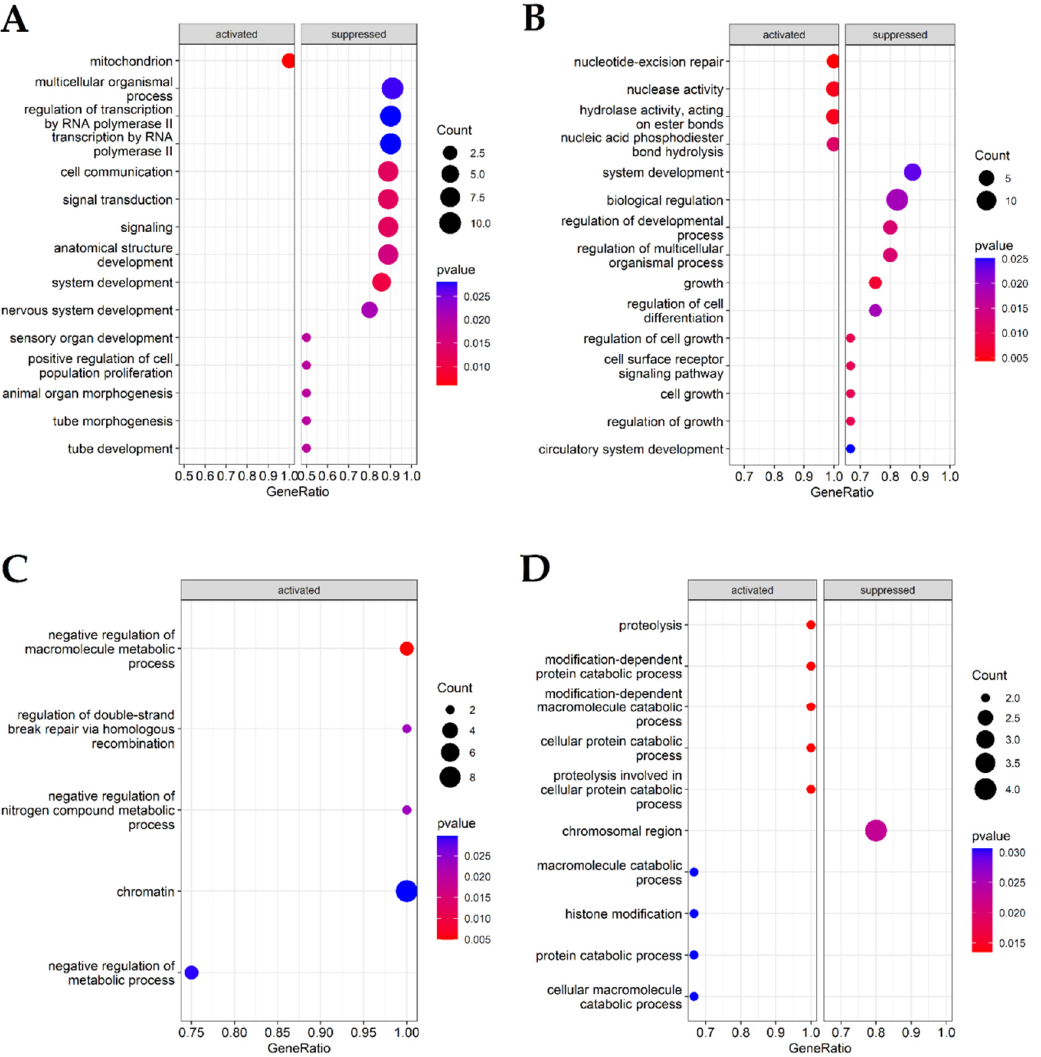
Figure 4. Results of gene set enrichment analysis (GSEA) analysis for genes selected from such comparisons, where more than ten genes were found to be indicative and differentially expressed. Up to the top 15 functional terms with the lowest p value are presented. ( A )—AAA vs. control; ( B )—CVD vs. control; ( C )—LEAD vs. AAA; ( D )—LEAD vs. CVD. AAA—abdominal aortic aneurysm, CVD—chronic venous disease, LEAD—lower extremity arterial disease.